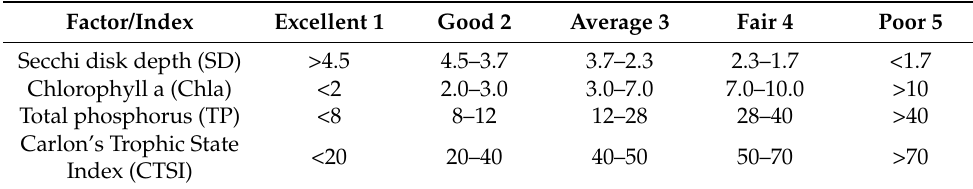
Table 9. Single indicator water quality